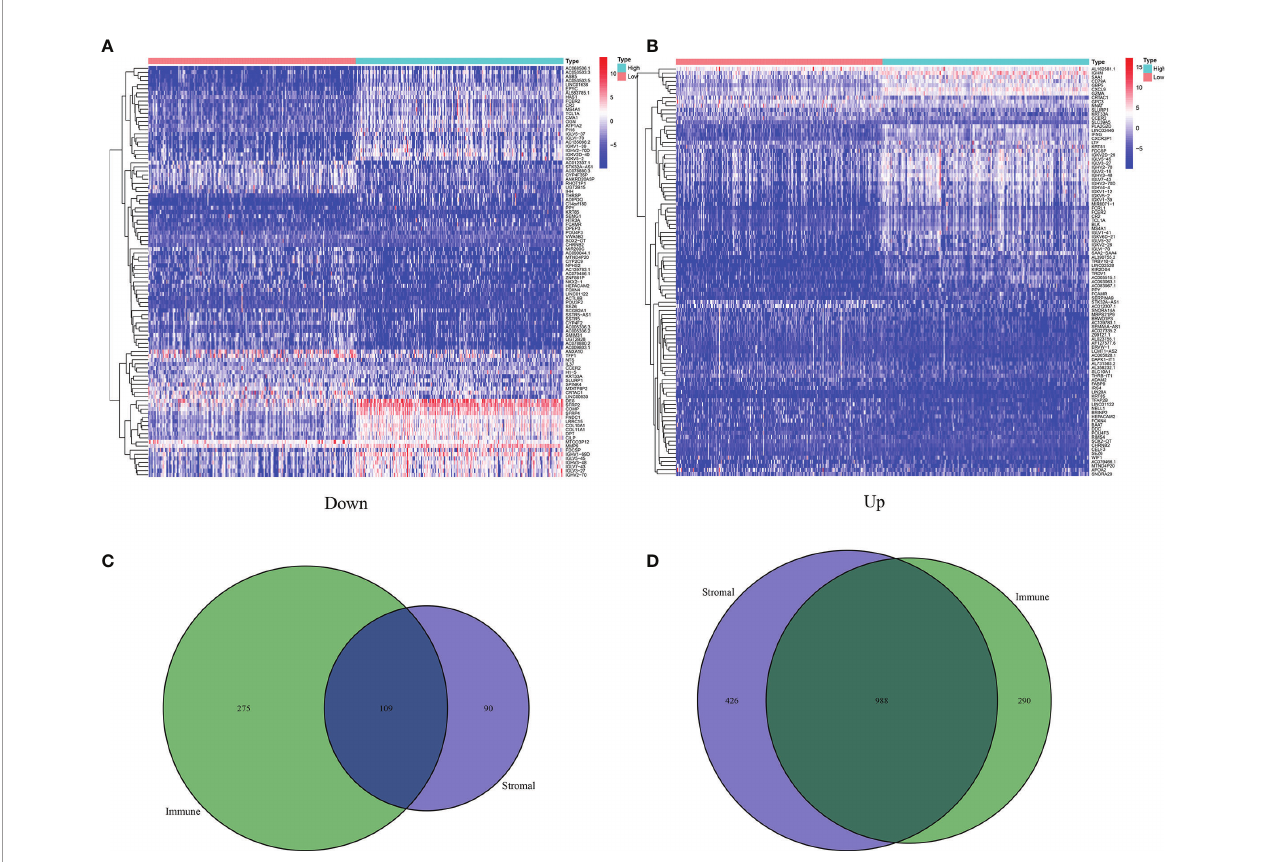
FIGURE 3 | Identi fi cation of 1,027 DEGs between ImmuneScore and StromalScore. (A) Heatmap for DEGs in ImmuneScore, only showing the top 60 signi fi cantly DEGs ( p < 0.05, fold change > 1.5). (B) Heatmap for DEGs in StromalScore, only showing the top 60 signi fi cant DEGs ( p < 0.05, fold change > 1.5). (C) Venn plots showing 109 DEGs that were commonly upregulated both in ImmuneScore and StromalScore. (D) Venn plots showing 988 DEGs that were commonly downregulated both in ImmuneScore and